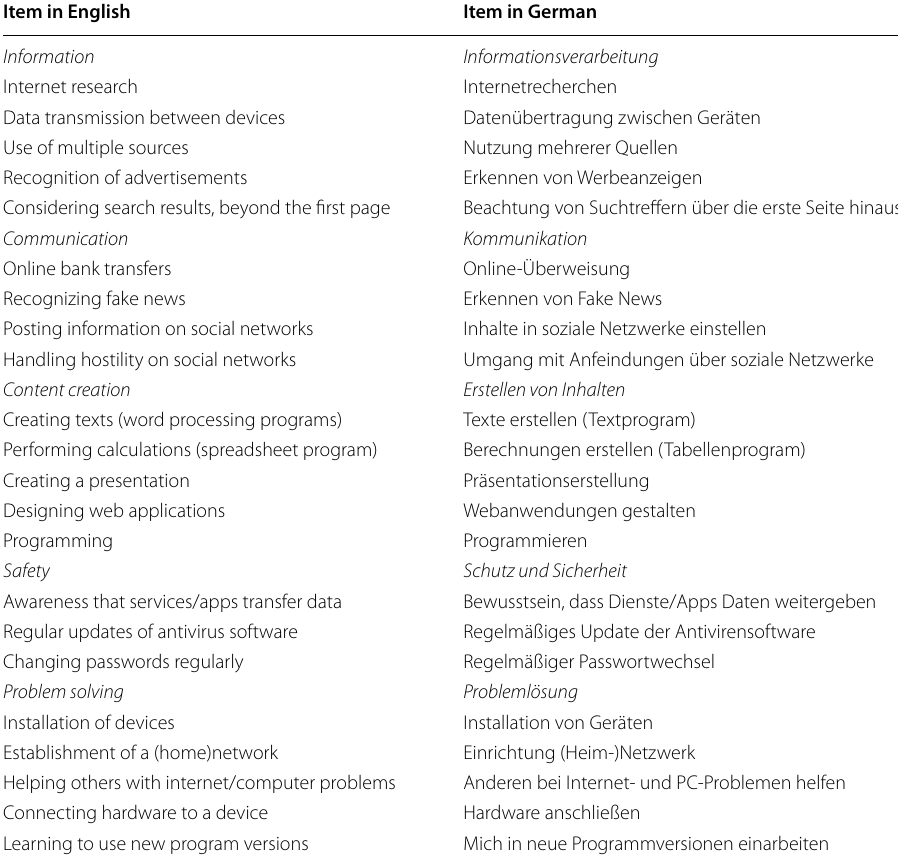
Text in the introduction: ‘Think about your digital skills. What can you do, recognize and what is your behavior?’